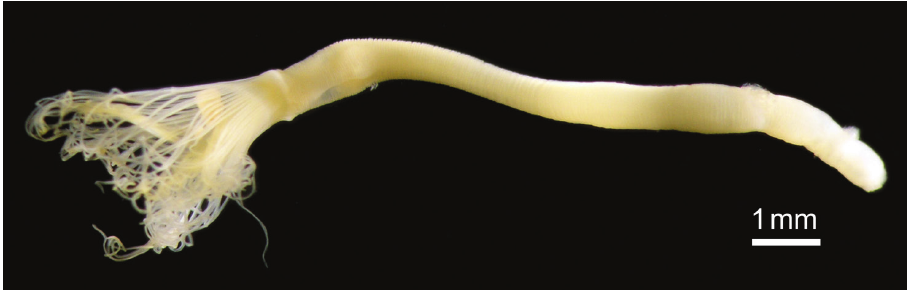
Figure 8. Phoronis emigi sp. n., NSMT-Te 714 (holotype), photographed in the preserved state (10% formalin seawater) before sectioning.